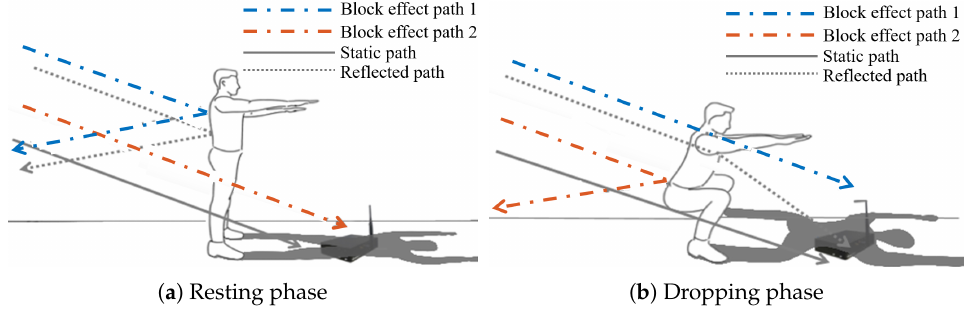
Figure 7. Impact of human motion on signal propagation